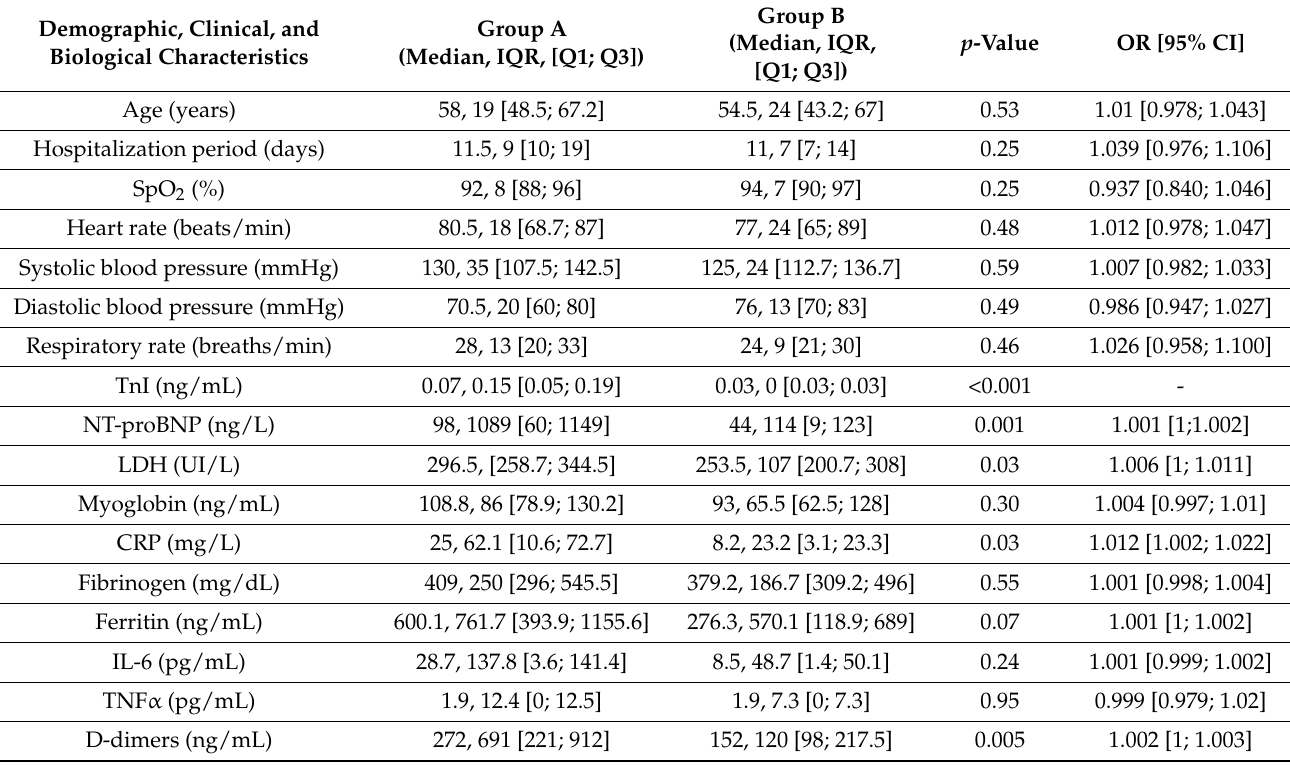
Table 2. Clinical and laboratory characteristics in COVID-19 patients with and without myocardial injury.